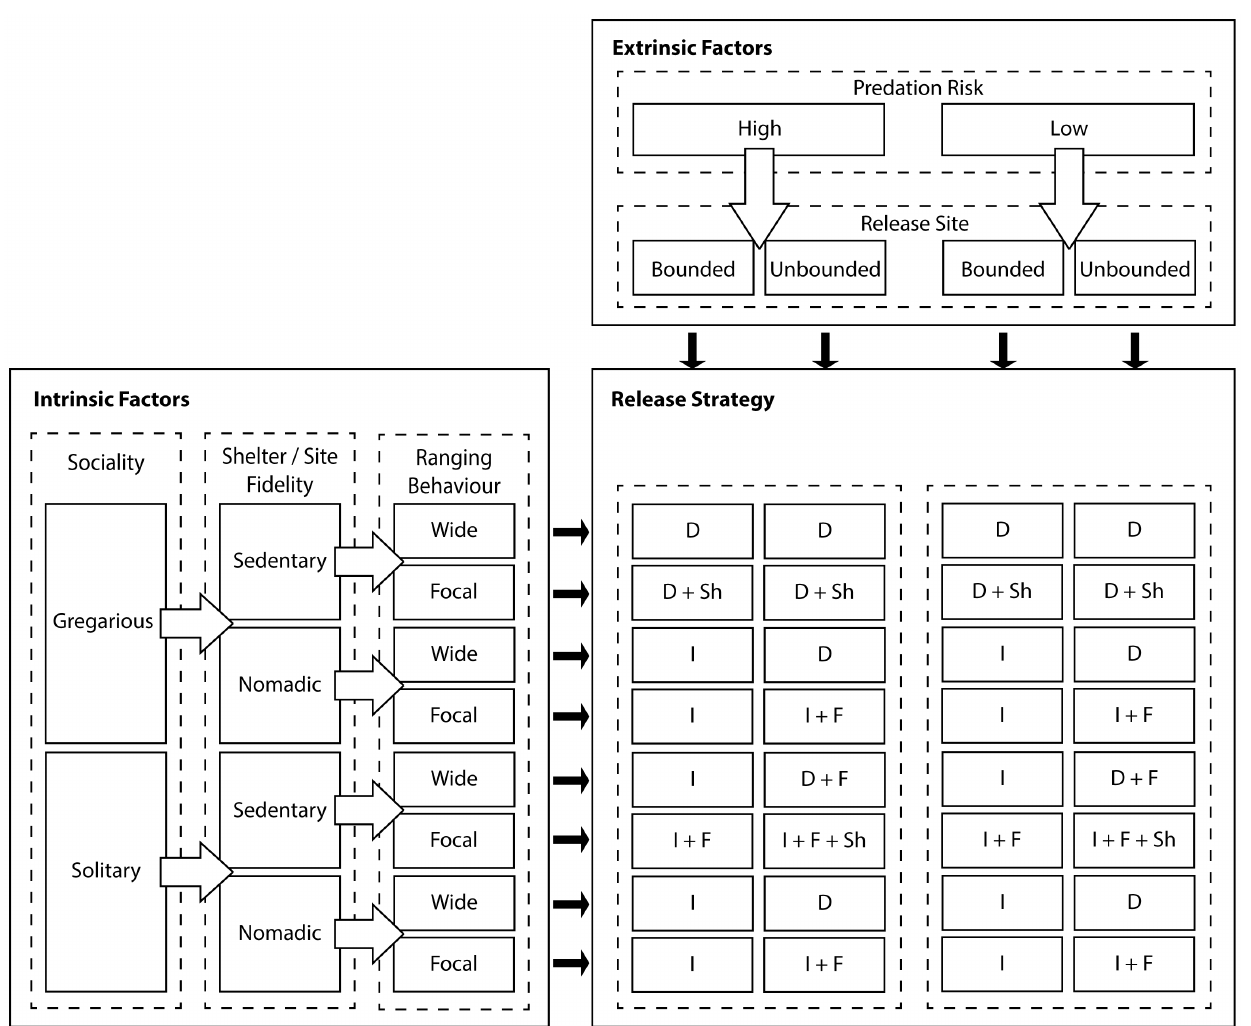
Figure 5. A predictive model based on current and previous studies which could be used as a basis for hypothesis testing regarding which release strategies are the most suitable for a given species reintroduction, depending on the site characteristics. The model could be tested against both captive-bred, and wild groups of release animals. Key to release strategies: I=immediate release, D=delayed release, F=supplementary food, Sh=supplementary shelter.